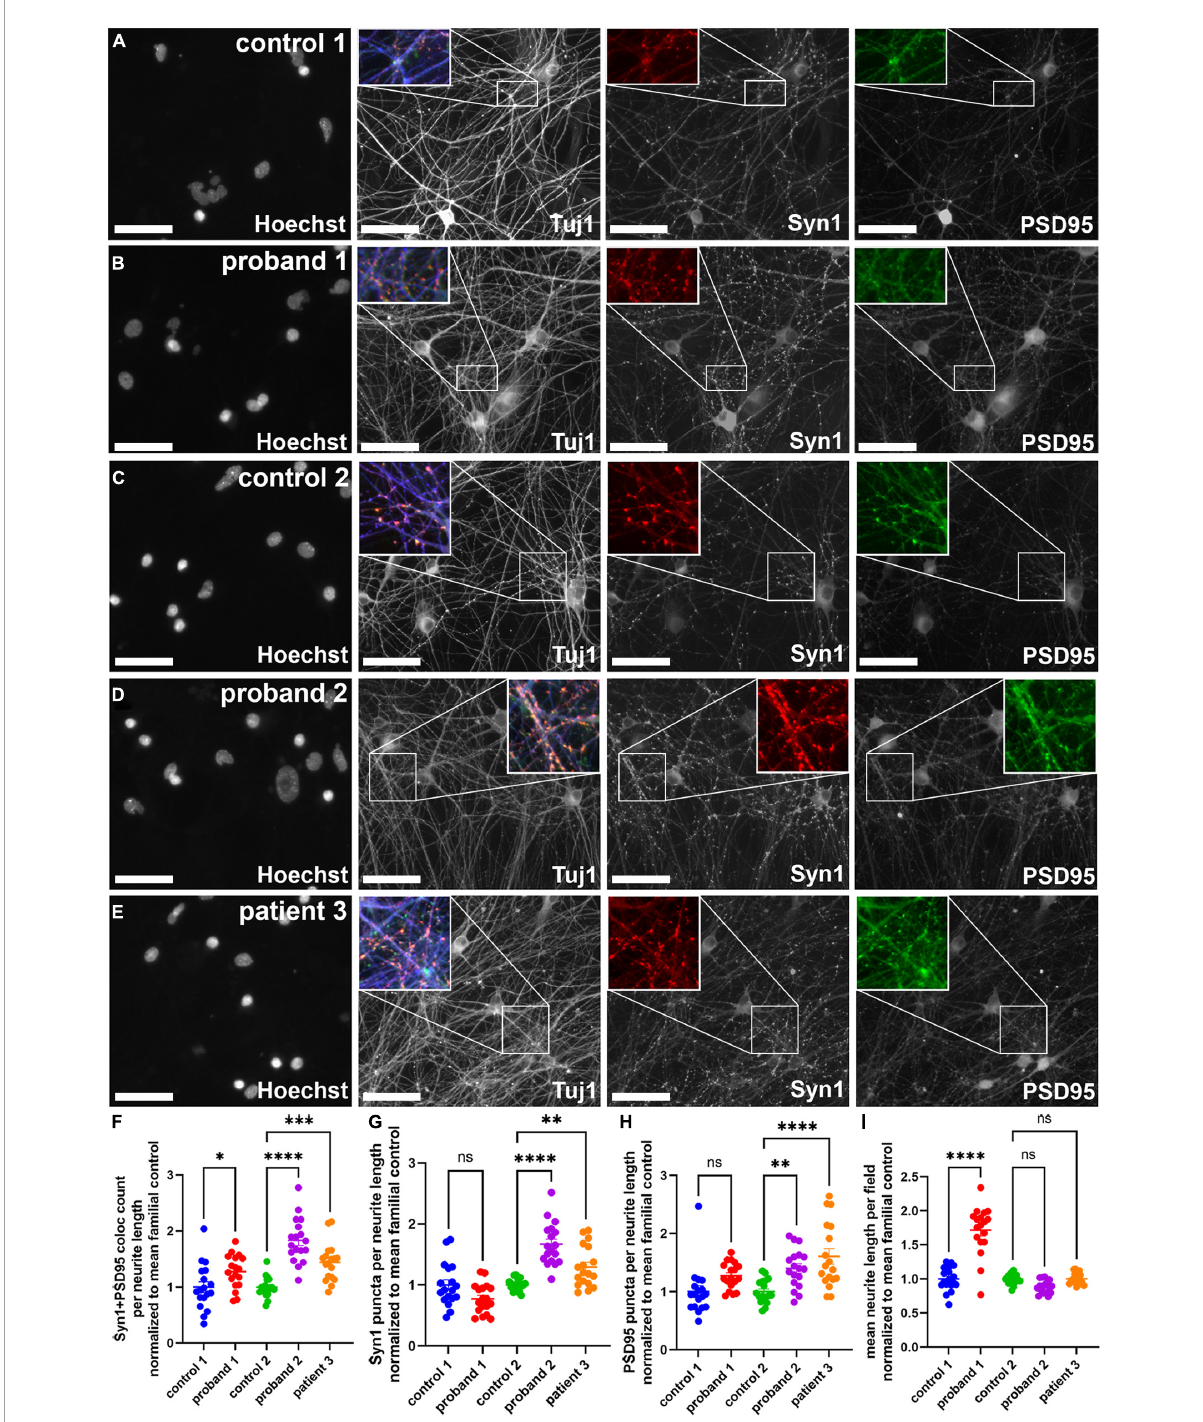
FIGURE4 Presumptive synapse count was increased in 16p13.11 deletion long-term cultures. (A,B) Representative images of control 1 (A) and proband 1 (B) long-term day 24 NGN2 neurons co-cultured with astrocytes and immunostained for Tuj1, Synapsin 1 (Syn1), and PSD95. Representative images of control 2 (C) , proband 2 (D) , and patient 3 (E) long-term day 24 NGN2 neurons co-cultured with astrocytes and immunostained for Tuj1, Synapsin 1 (Syn1), and PSD95. All images were captured at 20X. (F) Quantification of average Syn1 + PSD95 colocalized puncta per neurite length. (G) Quantification of Syn1 puncta per neurite length. (H) Quantification of PSD95 puncta per neurite length. (I) Quantification of mean neurite length per field. Scale bars = 50 µ m. In panels (F–I) data are shown as ± SEM, each data point represents a mean well value averaged from 9 fields per well across 5 differentiations, n.s. = not significant, ∗ p < 0.05, ∗∗ p < 0.01, ∗∗∗ p < 0.001. Pseudo-coloring was applied to allow for merged